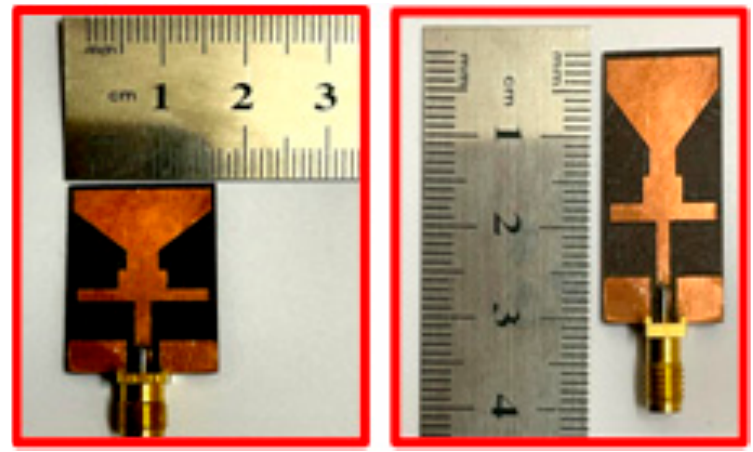
Figure 7. Hardware Prototype of proposed dual-band antenna.